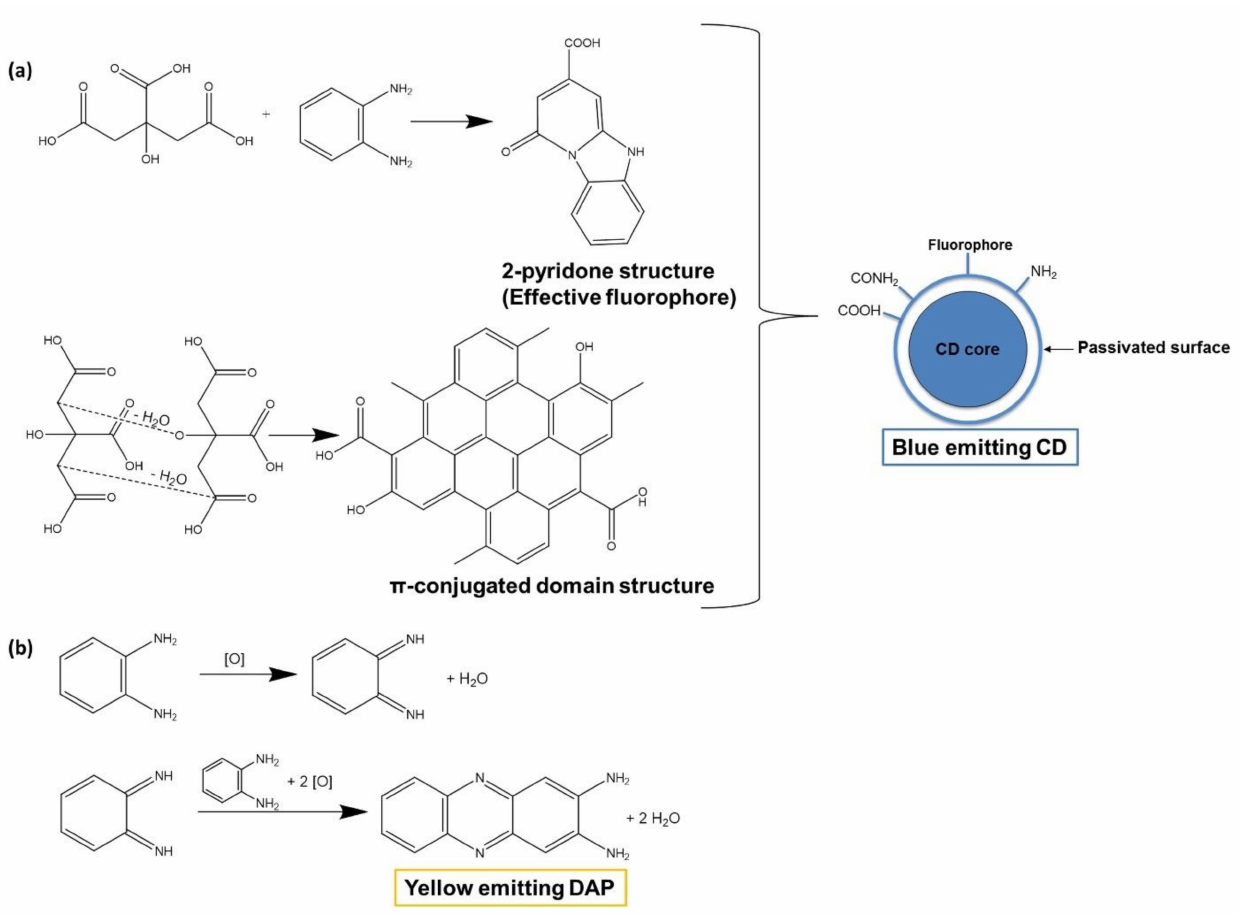
Figure 3. ( a ) Formation of CQDs from citric acid and o -phenylenediamine; ( b ) formation of DAP by oxidative dimerization of o -phenylenediamine. Reprinted from ref. [38], with permission from